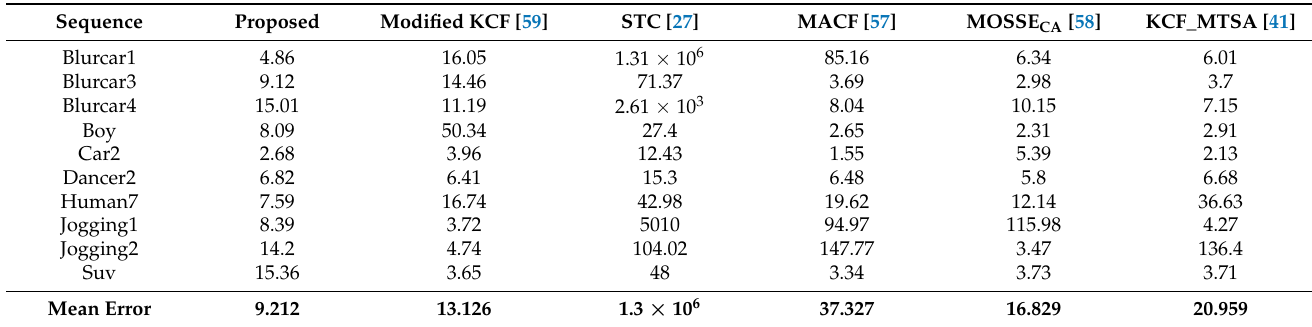
Table 2. Average center location